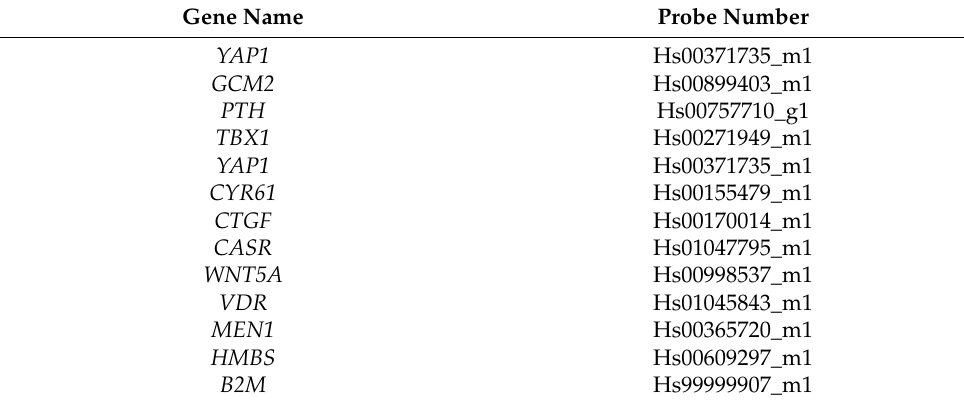
Table 2. Specific probes used for gene expression